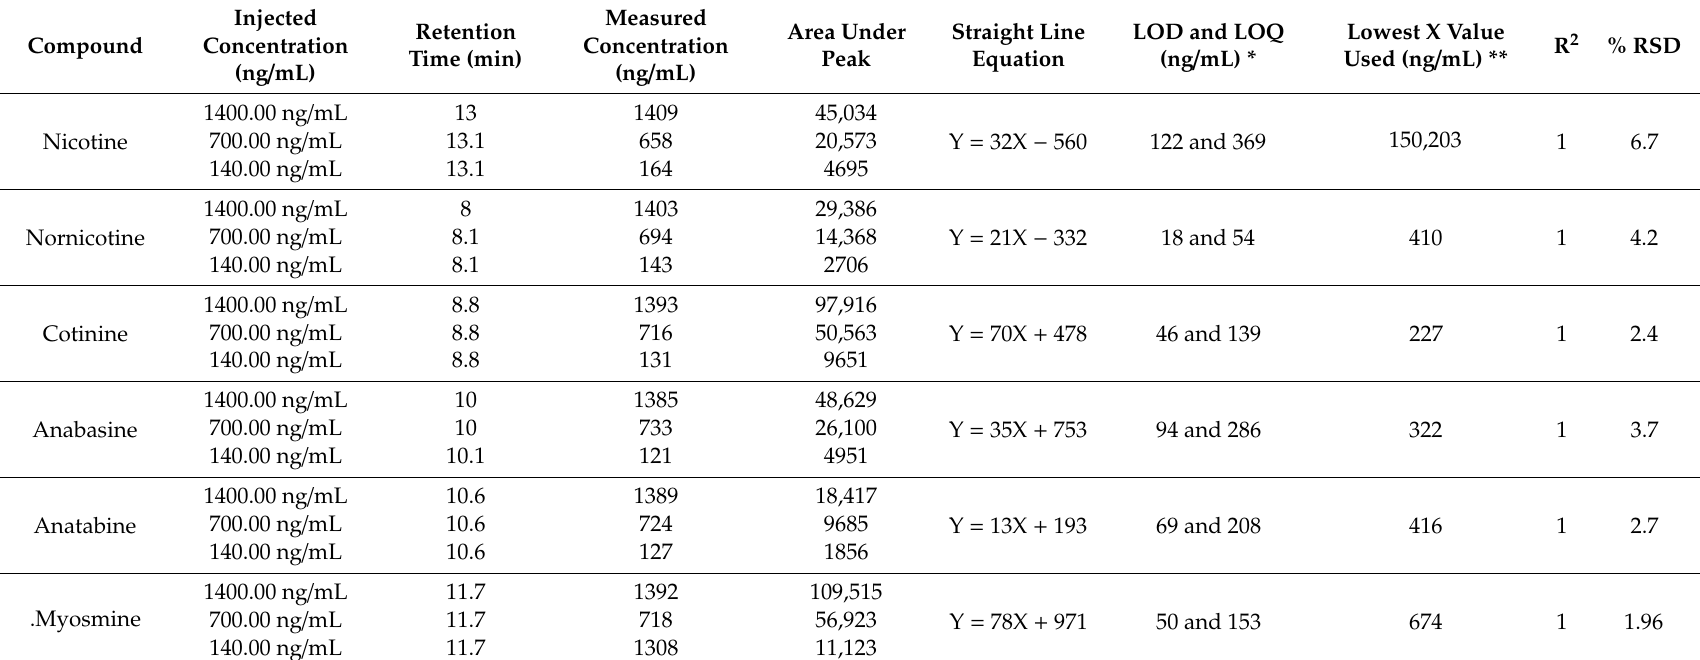
Table 2. Standard curve